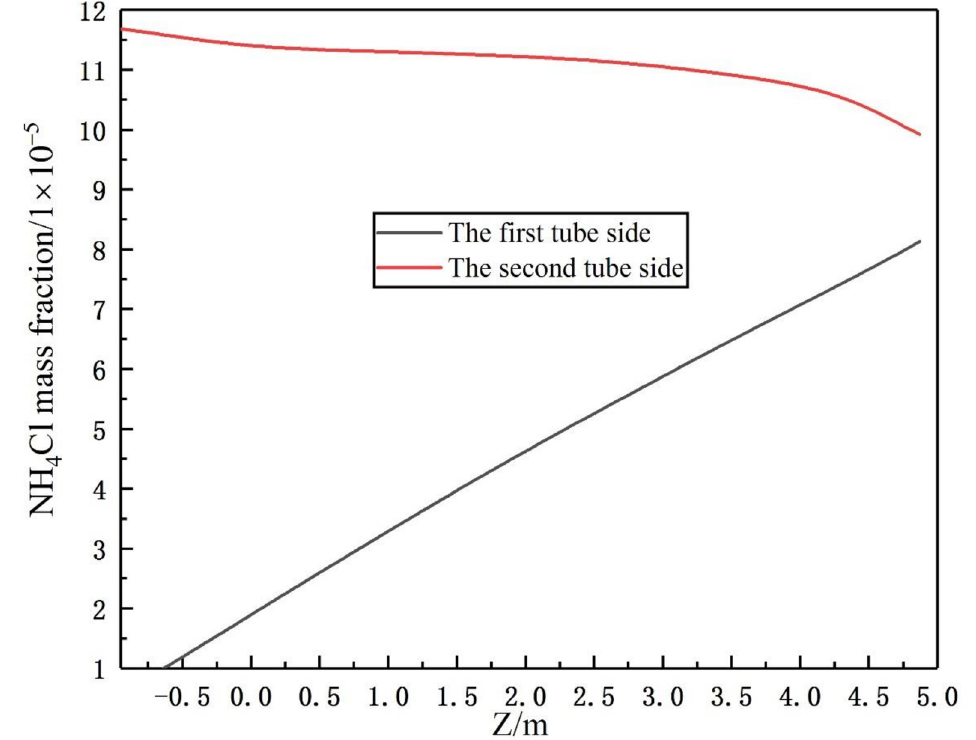
Figure 22. Crystal distribution of the seventh